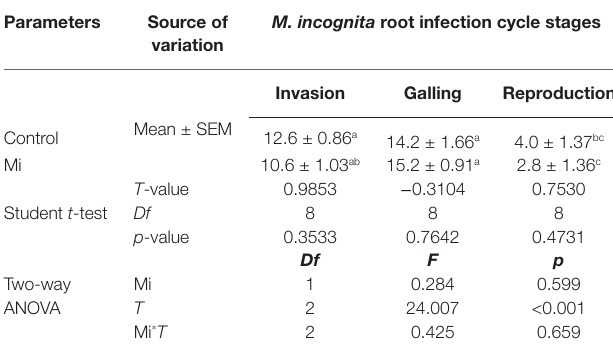
TABLE 1 | Number of nymphs produced by Macrosiphum euphorbiae adults on tomato plants.